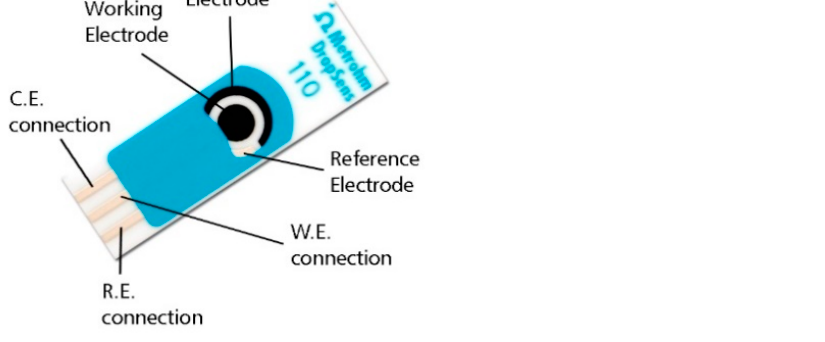
Figure 1. Schematic representation of the screen-printed electrodes used in this study.